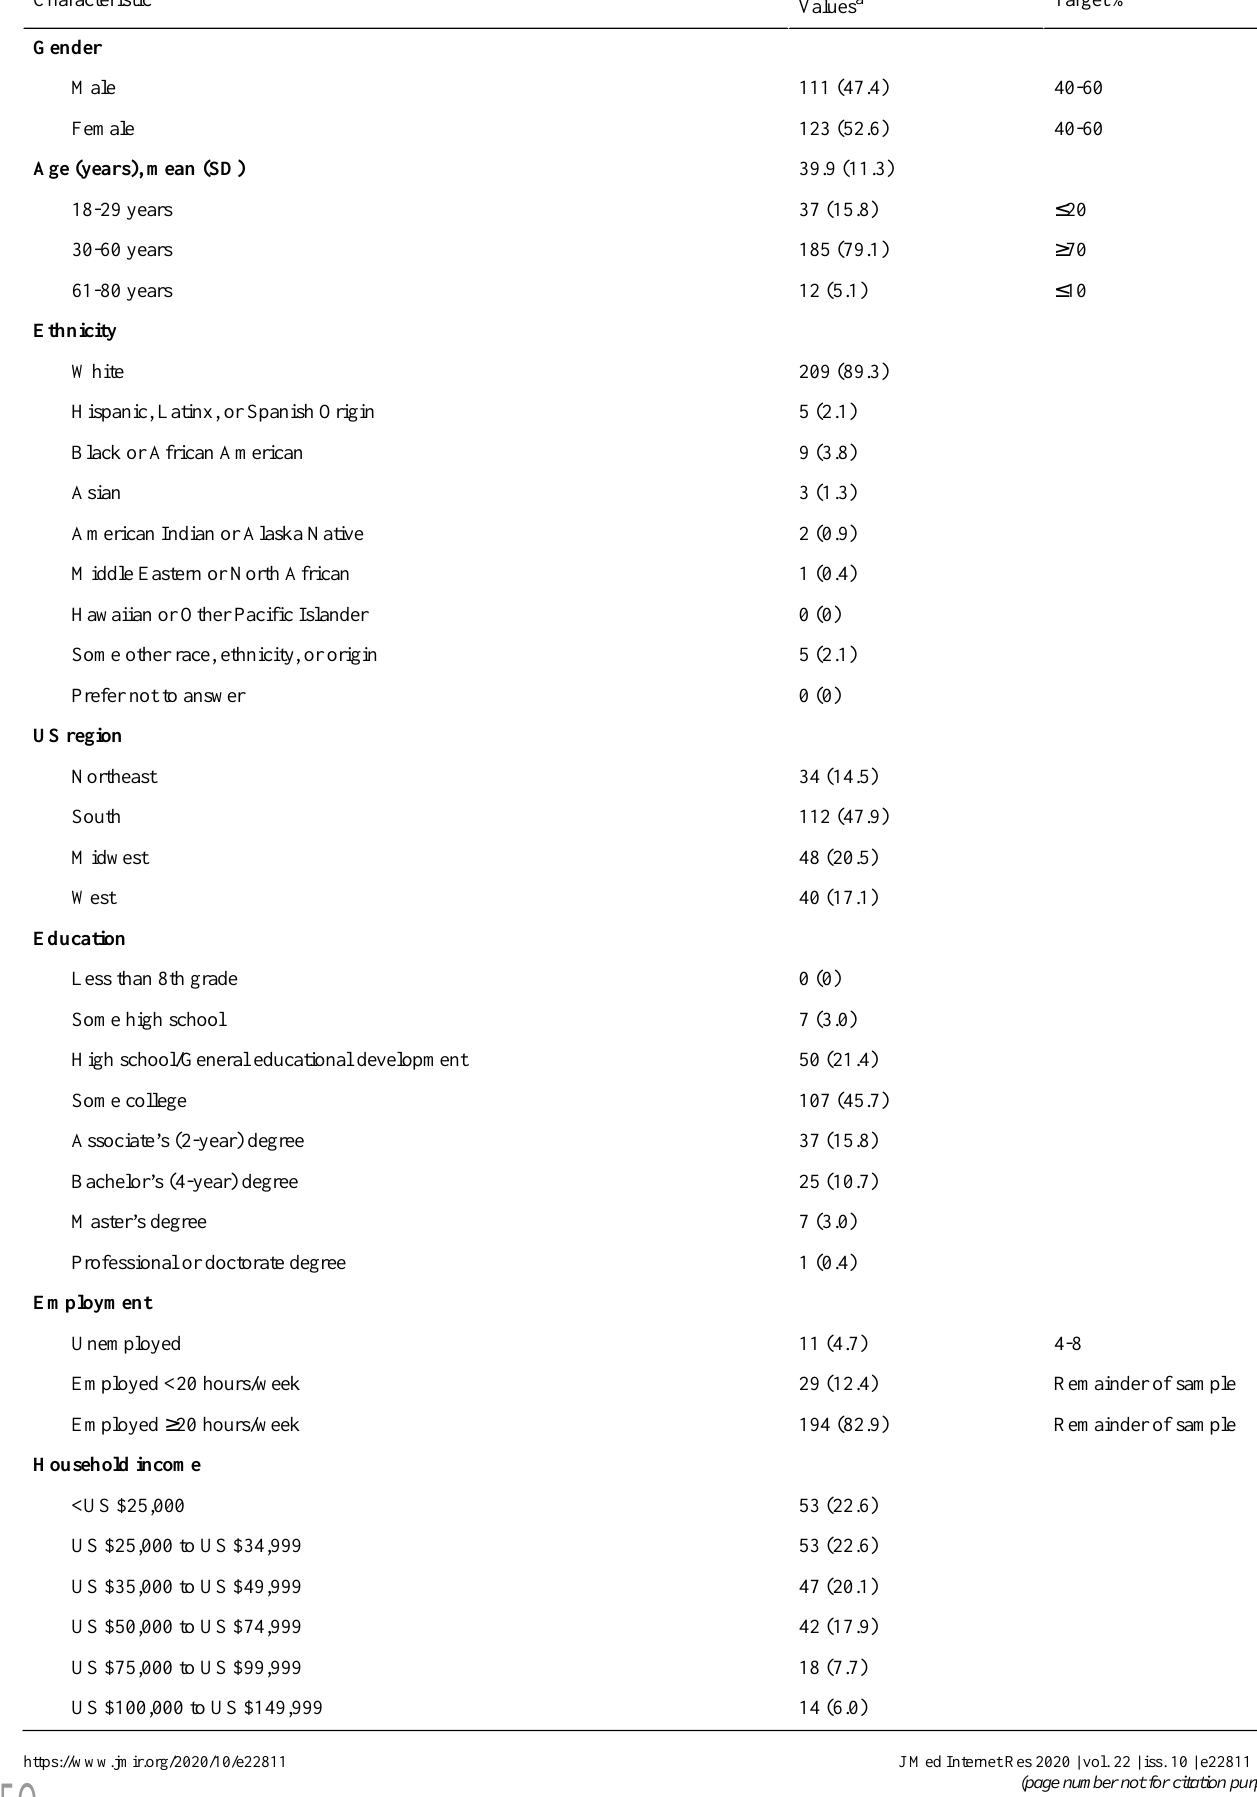
Table 3. Baseline demographics including targeted and actual nonproportional quota sampling (N=234, when